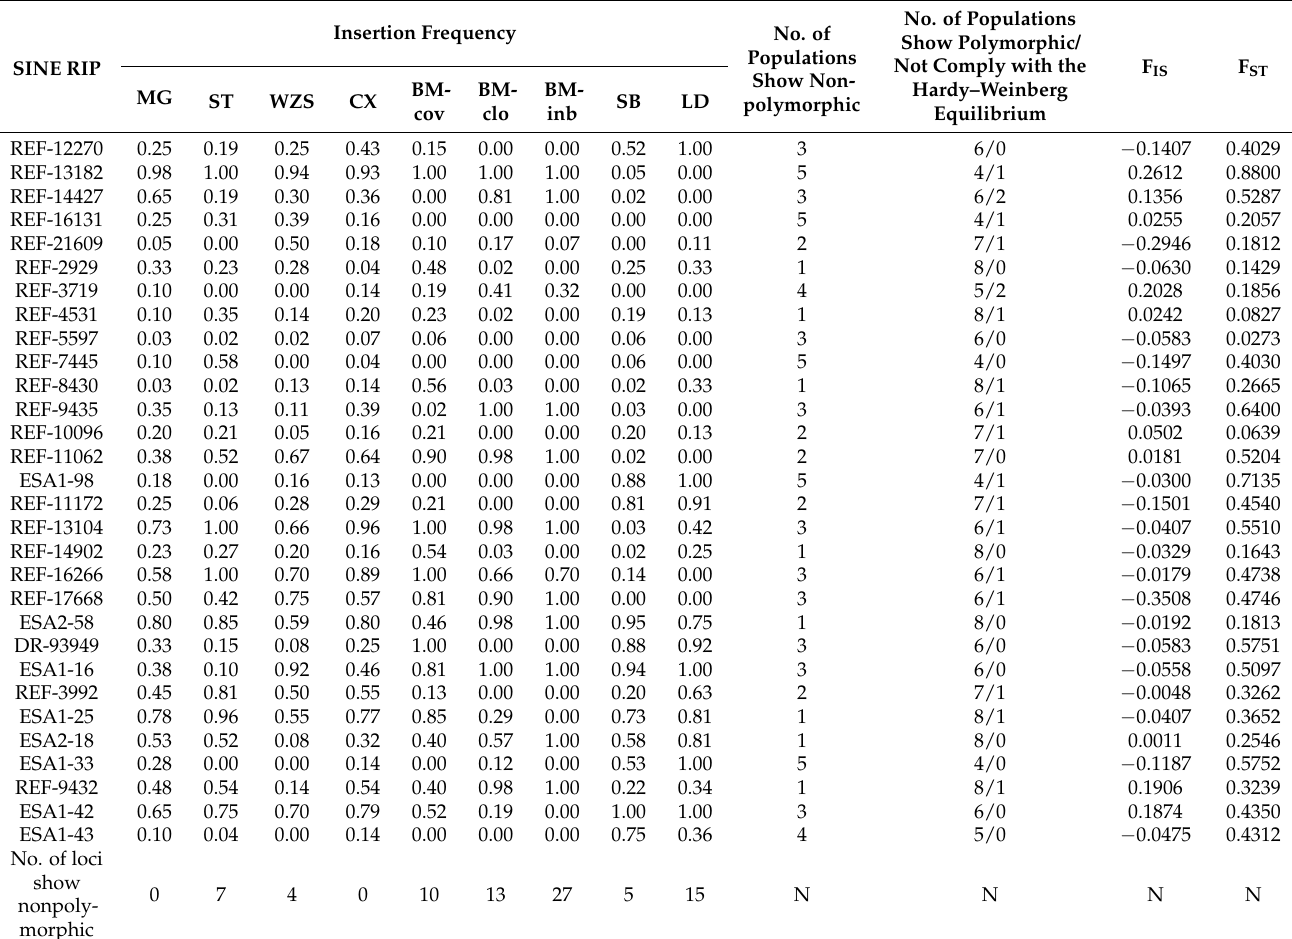
Table 1. Polymorphism of insertion sites in seven Chinese pig